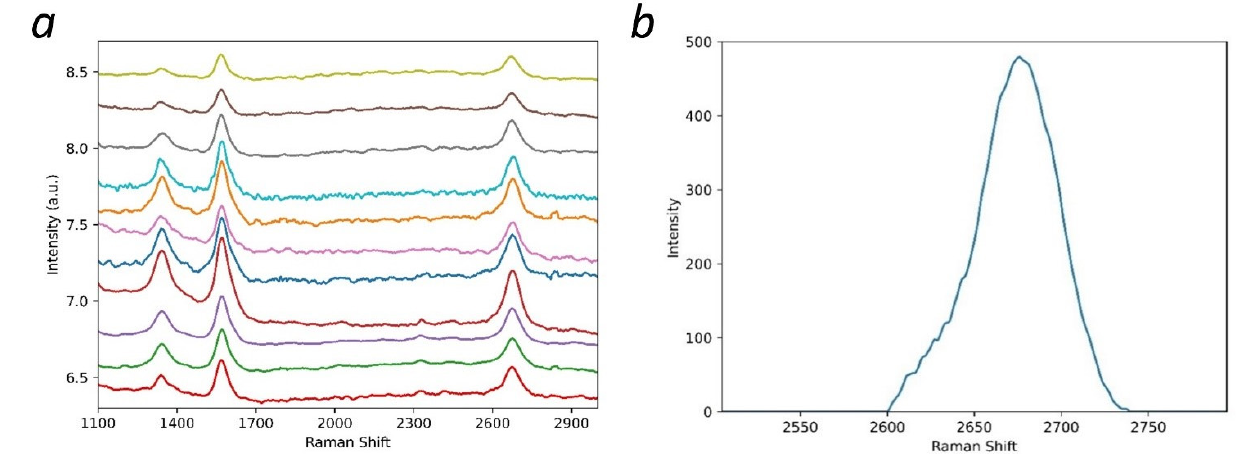
Figure 3. ( a ) Raman spectra for eleven random samples of the multilayer graphene powder and ( b ) 2D peak after baseline removal.